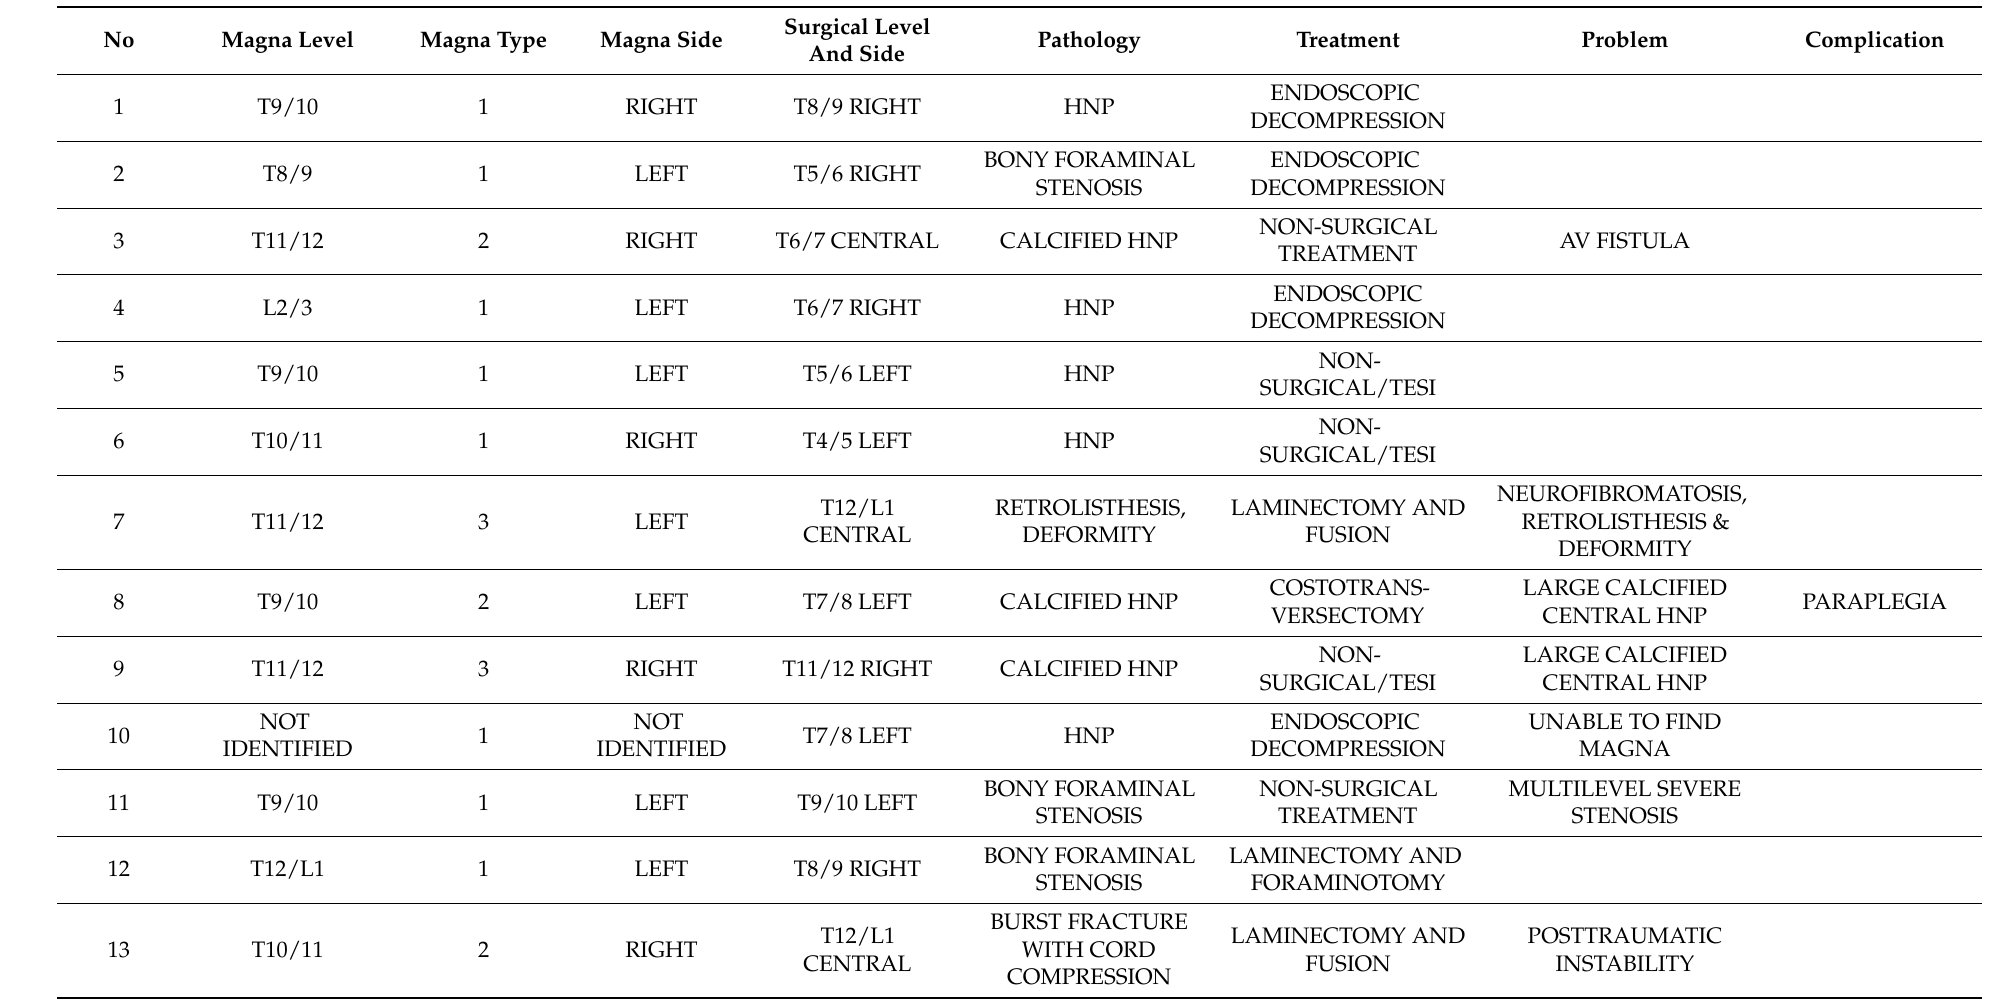
Table 4. Clinical data of study